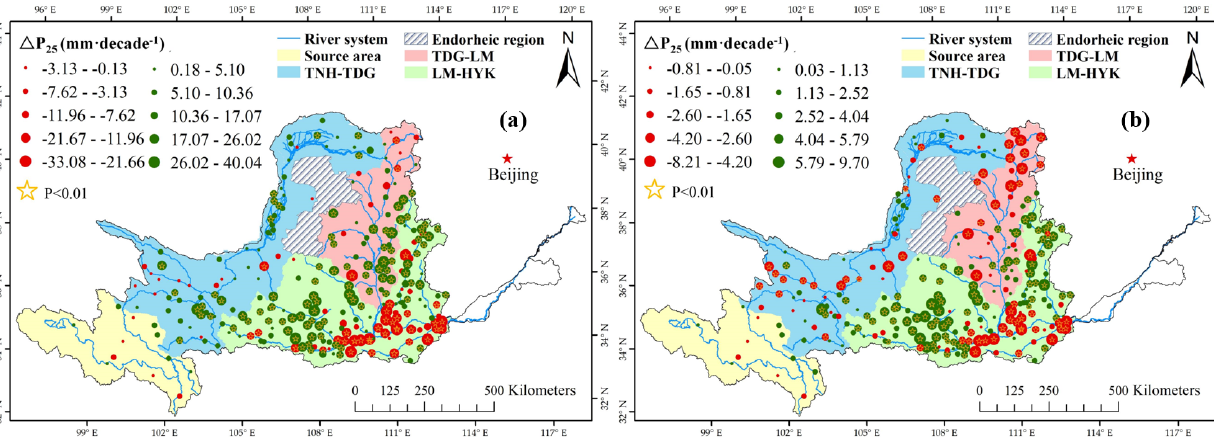
Figure 10. The impacts ( P 25 ) of changes in interannual precipitation (a) and intra-annual monthly to annual precipitation ratio (b) on the P 25 trend of each station. Hollow yellow stars show P 25 time series with statistically significant trends ( P < 0 . 01).